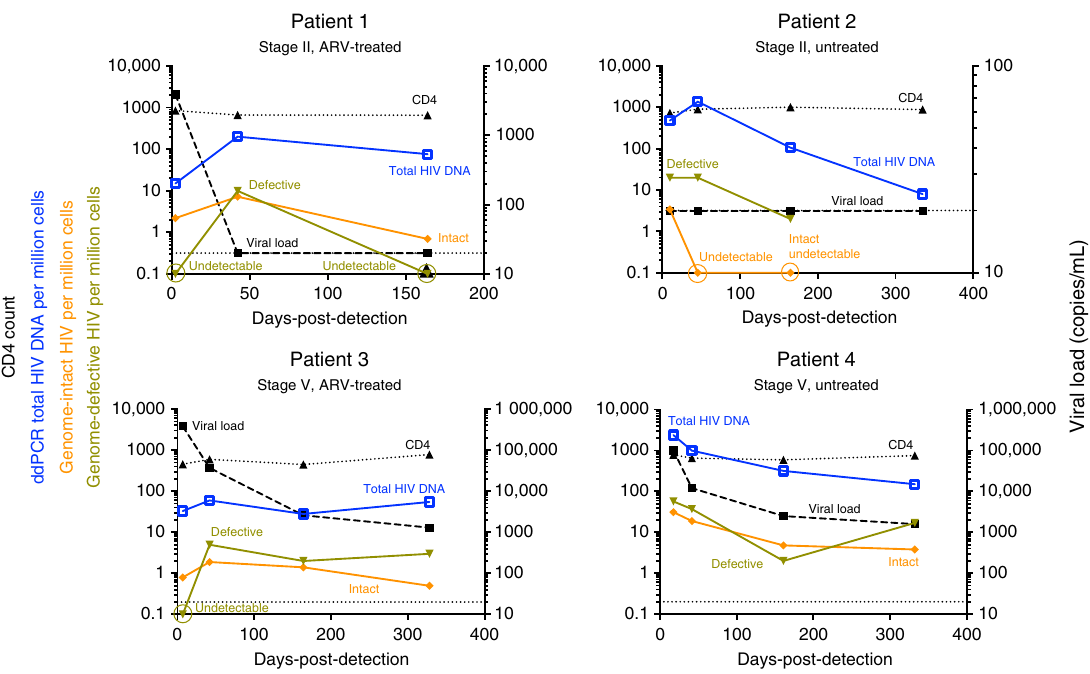
Fig. 1 Clinical and virological characteristics of the four study participants. Longitudinal trends of viral load (dashed black lines), CD4 counts (dotted black lines), absolute frequencies of genome-intact HIV-1 per million PBMCs (orange lines), absolute frequencies of genome-defective HIV-1 (light green lines), and total HIV-1 DNA burden determined by ddPCR (blue lines) are shown. Acute HIV-1 infection was staged according to the classi fi cation system of Fiebig et al.